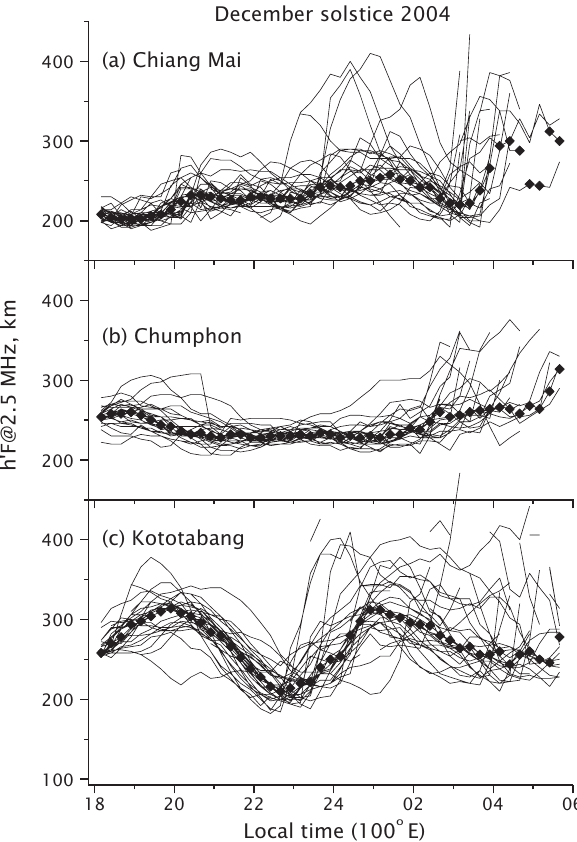
Fig. 5. Virtual height at 2.5MHz at Chiang Mai (a) , Chumphon (b) , and Kototabang (c) for the period from 7 December 2004 to 5 January 2005 (December solstice). Solid lines are for individual days and diamonds are monthly median values.